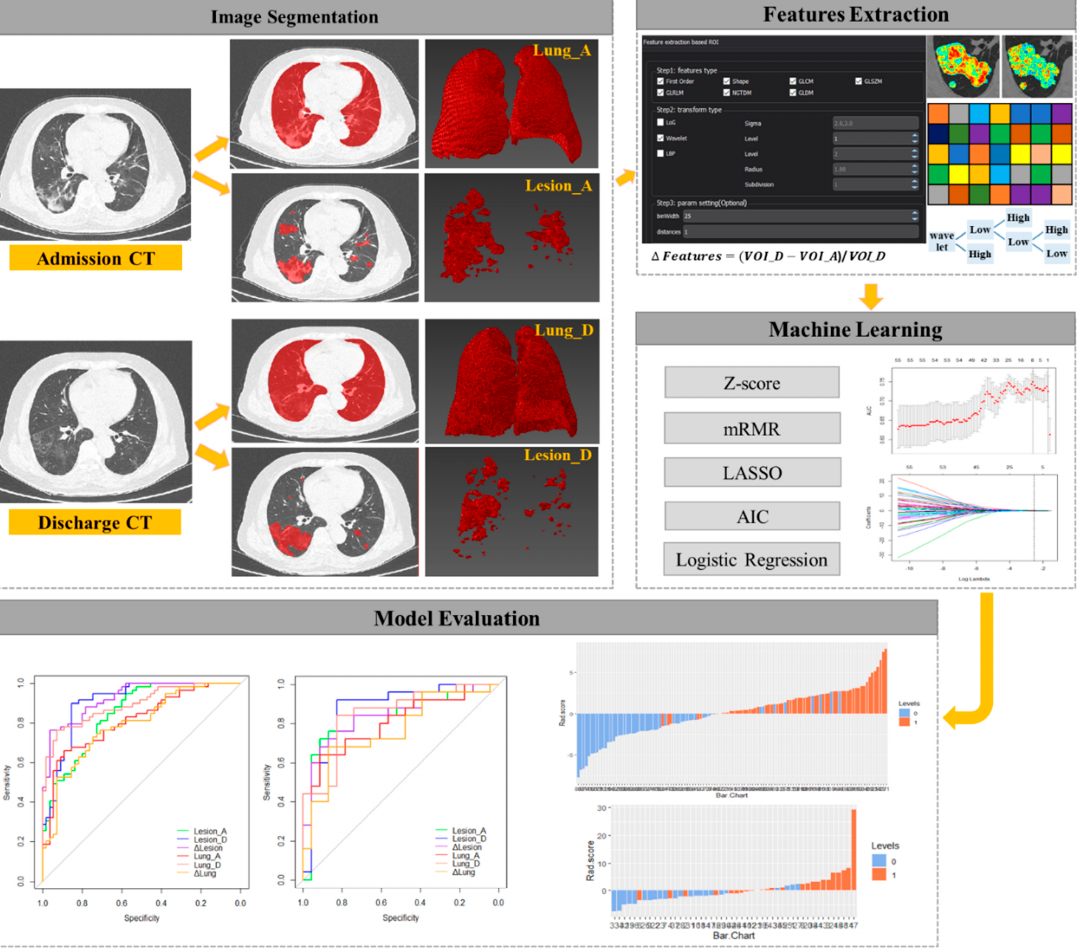
Figure 1. The workflow of the radiomic research.